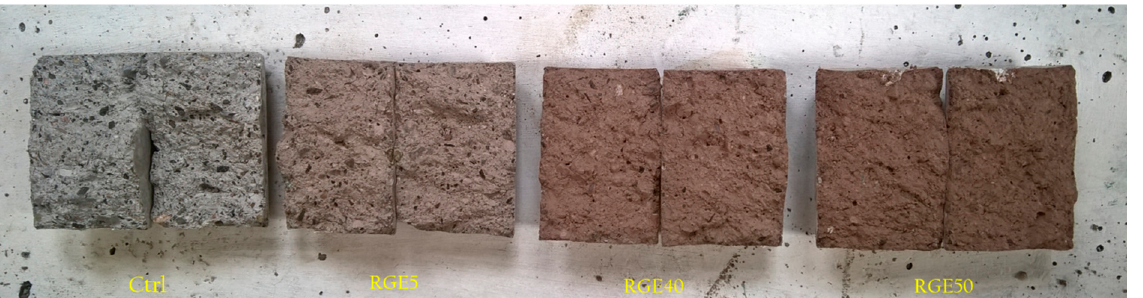
Figure 9. Samples after splitting tensile strength test.